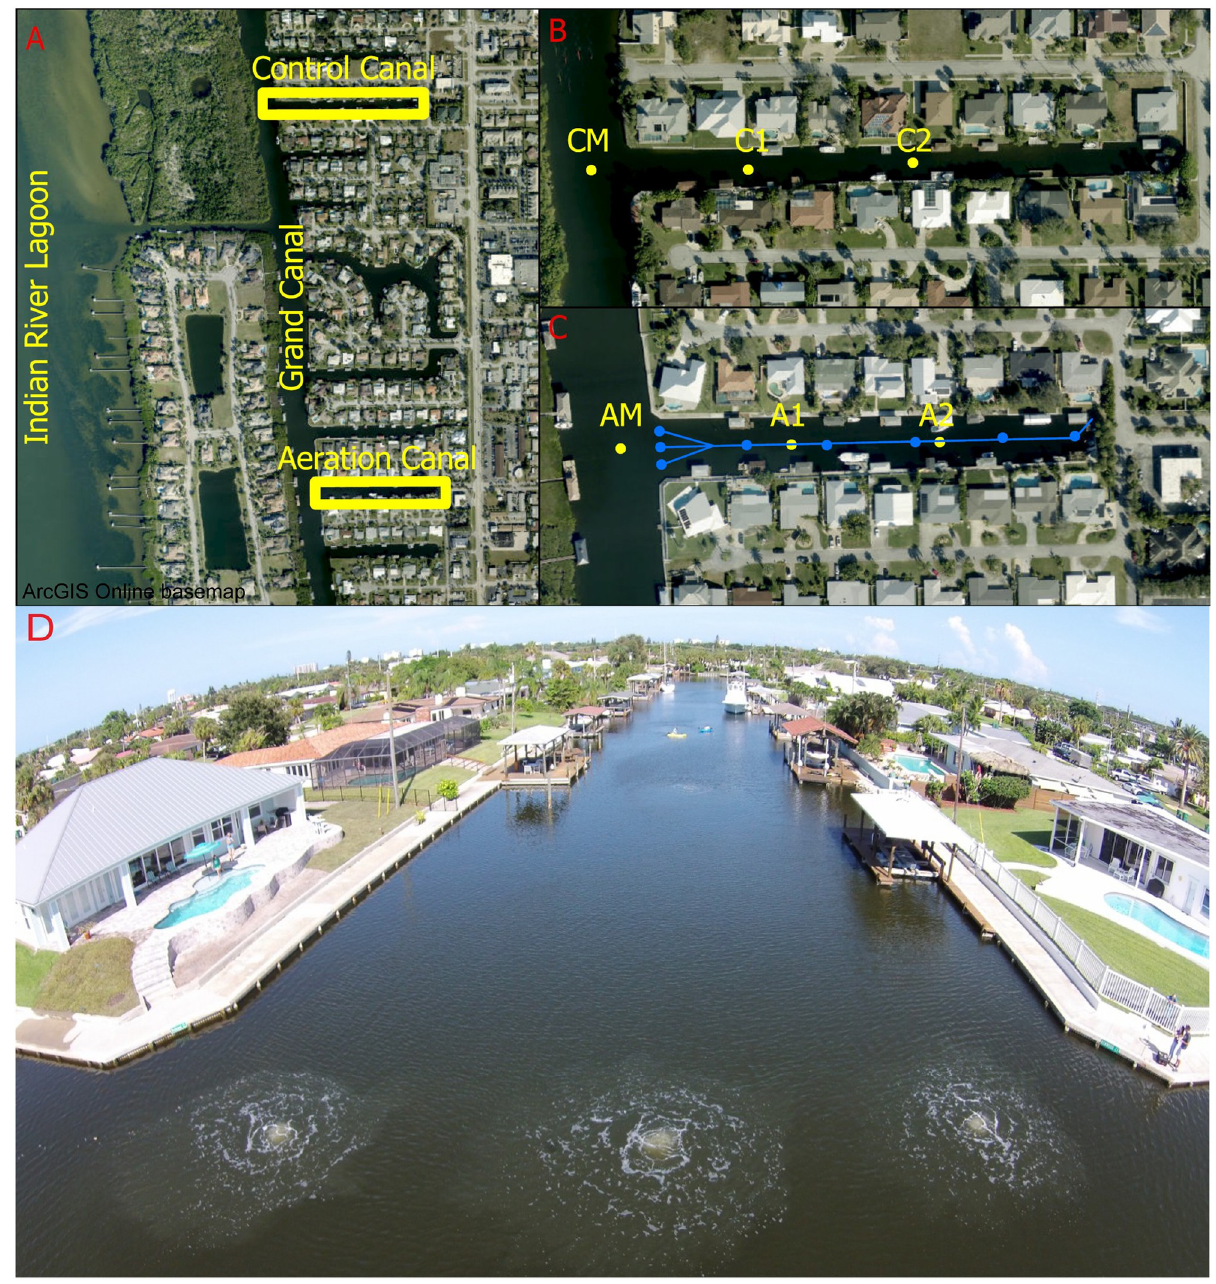
Fig 1. Study locations in (A) Aeration Canal and Control Canal, adjacent to the Grand Canal in Satellite Beach. (B) Control Canal sampling stations (yellow dots: C1 = Control 1; C2 = Control 2). (C) Aeration Canal sampling stations (yellow dots: A1 = Aeration 1; A2 = Aeration 2). CM (Control mouth in Grand Canal) and AM (Aeration mouth in Grand Canal) are intermedia sites in the Grand Canal; blue dots are aeration diffusers and blue lines are sunken aeration tubing. The maps for (A), (B) and (C) were generated from ArcGIS Online basemap [43] (D) A picture of aeration canal with diffusers